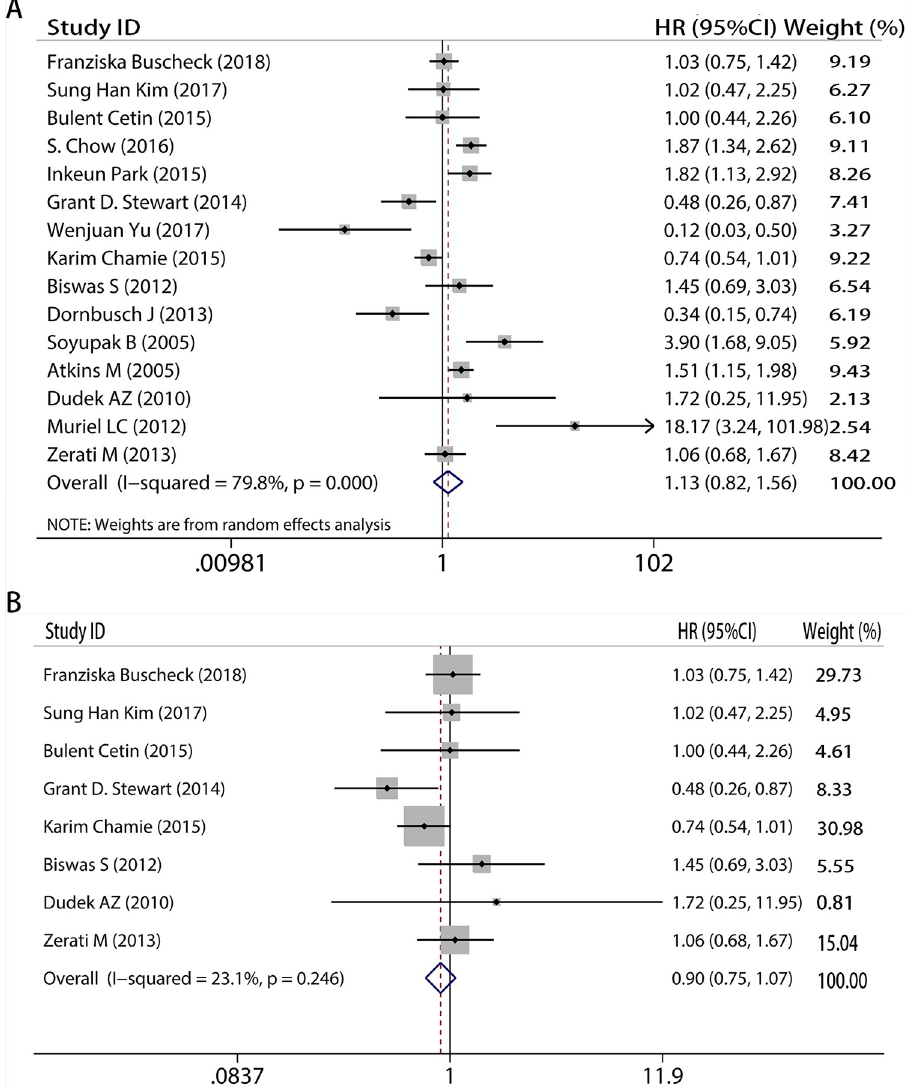
Fig 3. Meta-analysis of CAIX expression and overall survival on A, all inclusion studies; B, by excluding the low quality score studies (quality score �